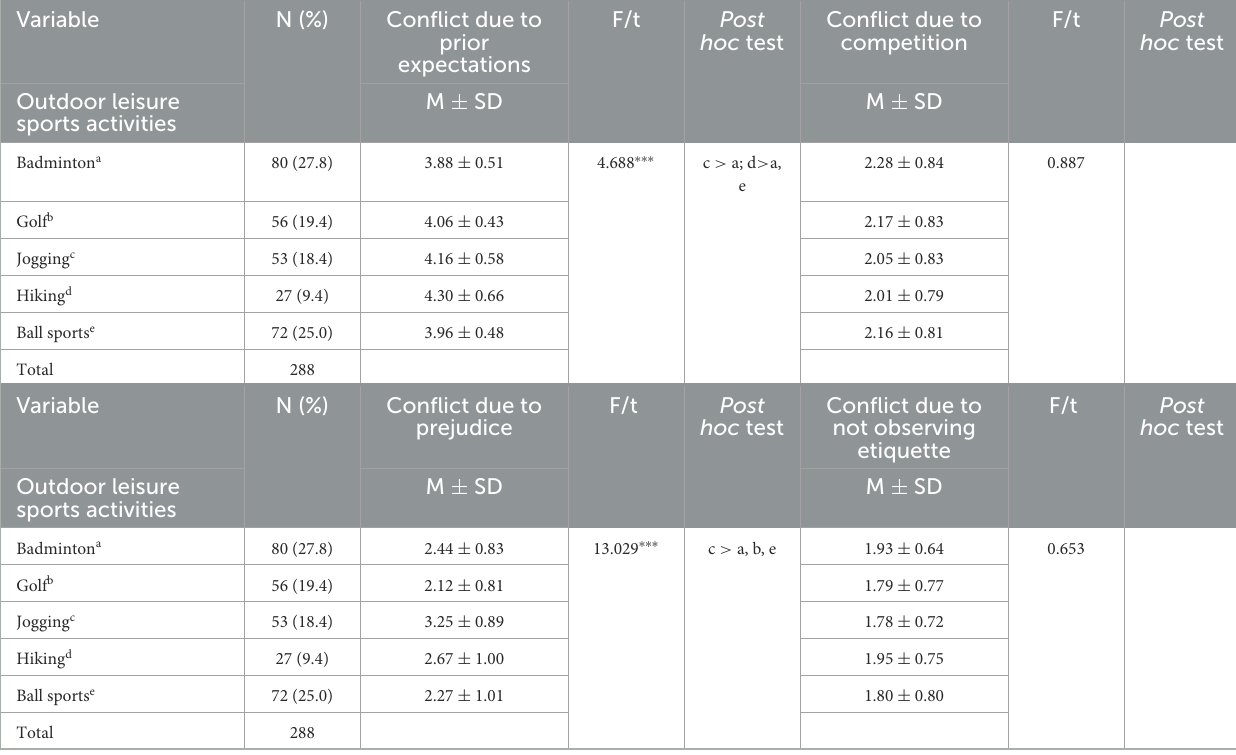
TABLE 2 Differences in leisure conflicts among outdoor leisure sports ( N =